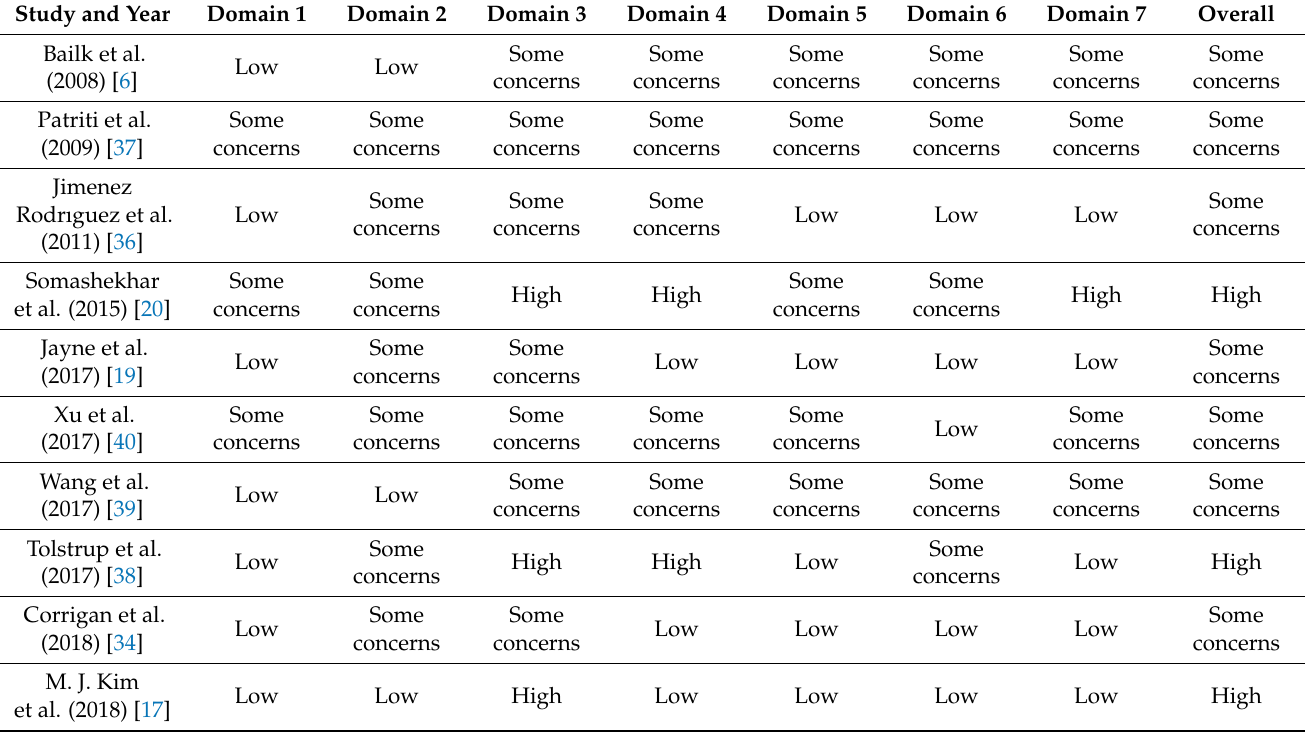
Table 2. Risk of bias assessment using the RoB2 tool for randomized controlled